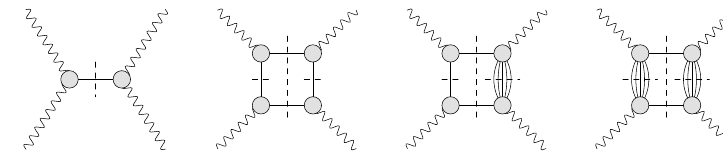
Figure 1. Unitarity diagrams according to the Mandelstam representation. Crossed diagrams are omitted.